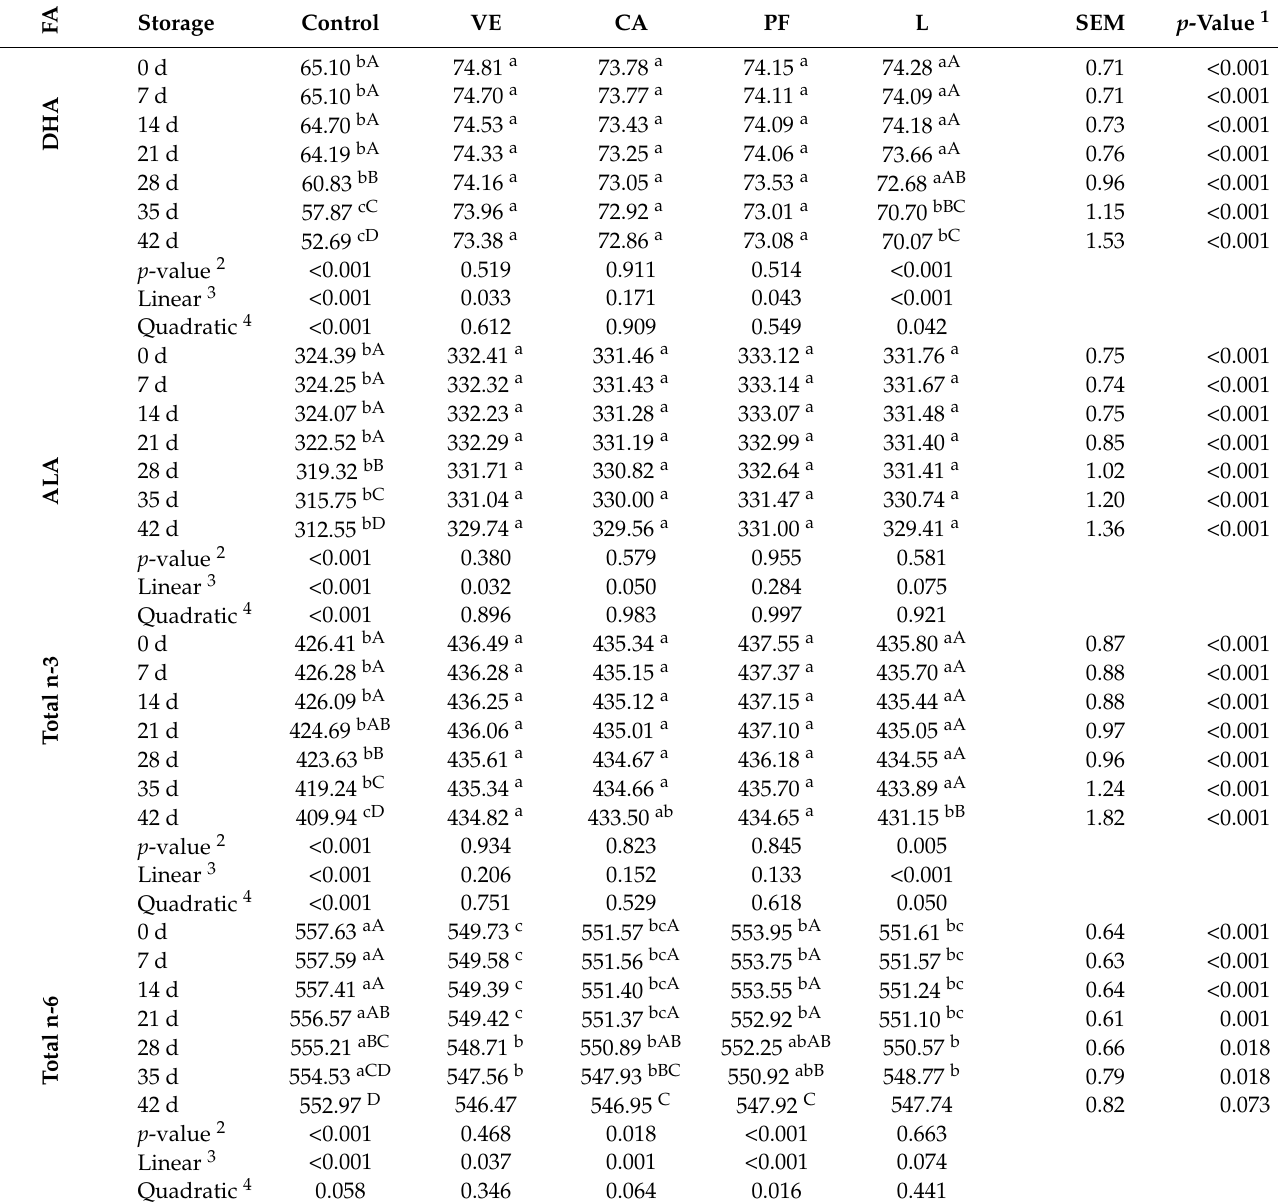
Table 6. The effect of different antioxidants on the DHA, ALA, Tn-3, and Tn-6 of egg yolk during storage, expressed as